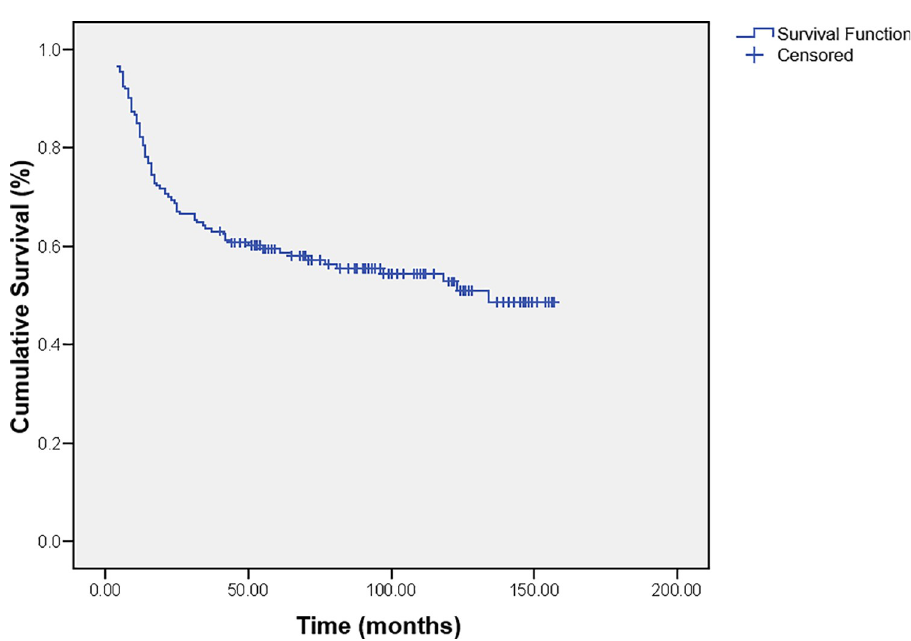
Fig 1. Cumulative survival of children with brain tumors.